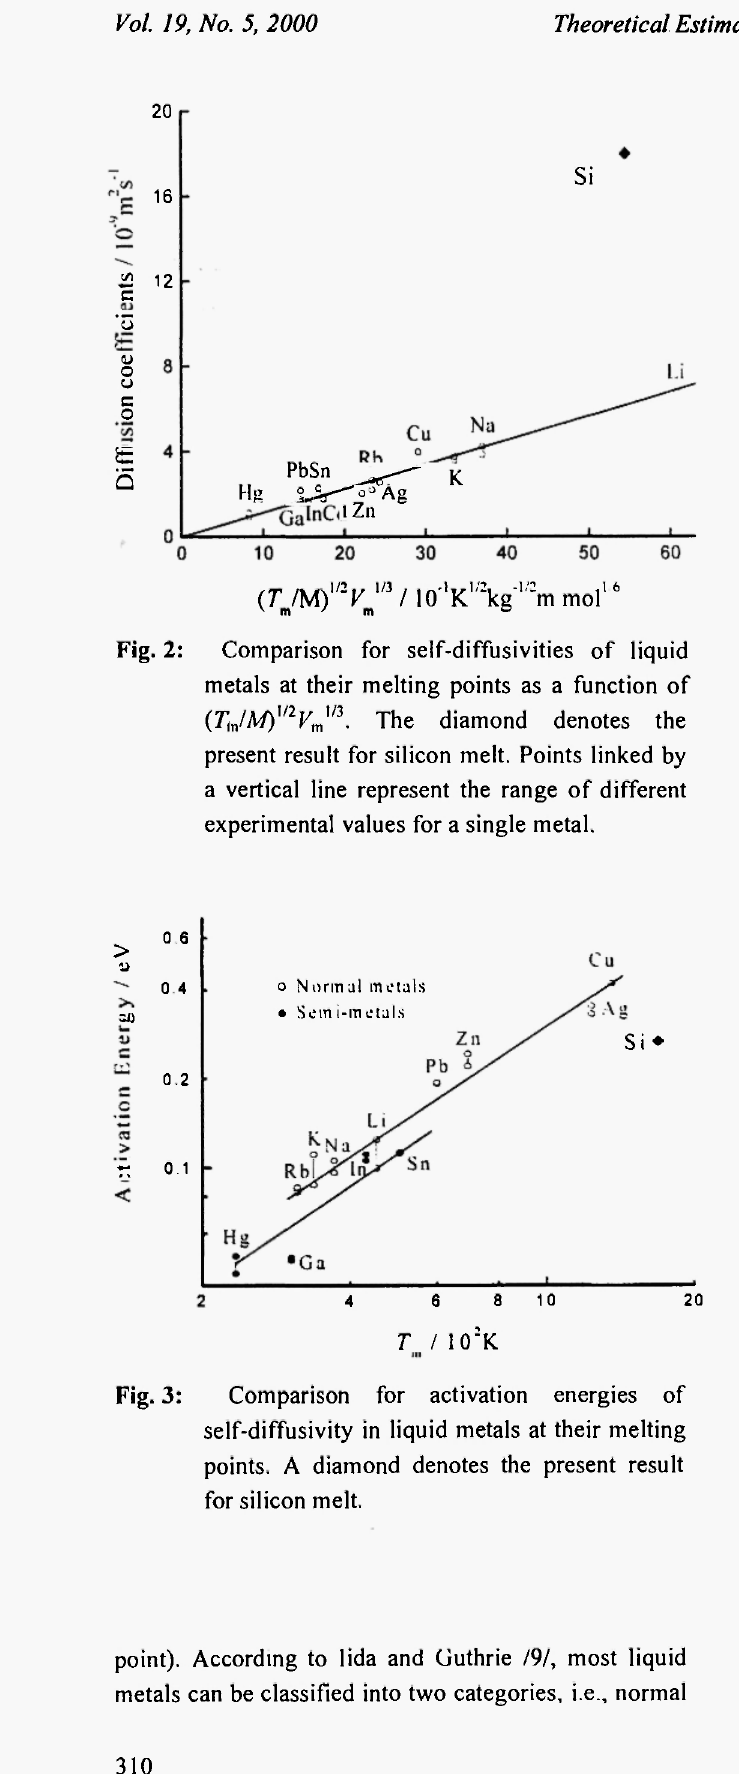
Fig. 3: Comparison for activation energies of self-diffusivity in liquid metals at their melting points. A diamond denotes the present result for silicon